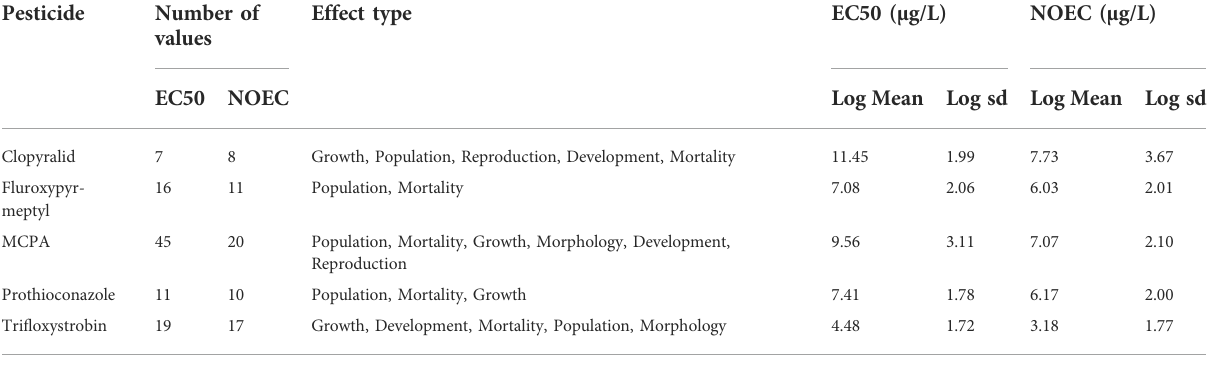
TABLE 4 Effect (toxicity) data collected for this study, detailing the effect types per pesticides and the derived EC50 and NOEC natural log(ln) mean and standard deviation for the natural log distributions. Pesticide